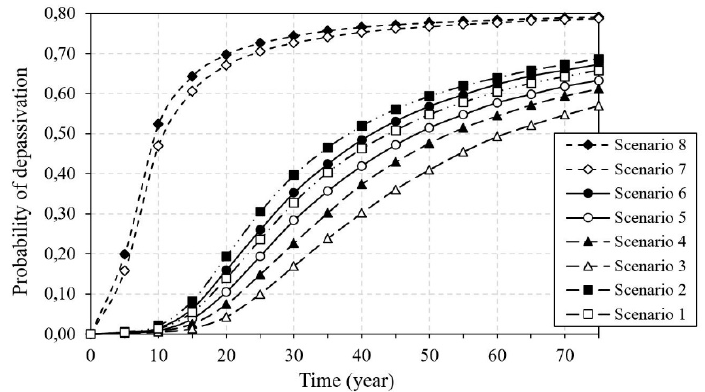
Figure 7. Probability of depassivation as a function of time for different